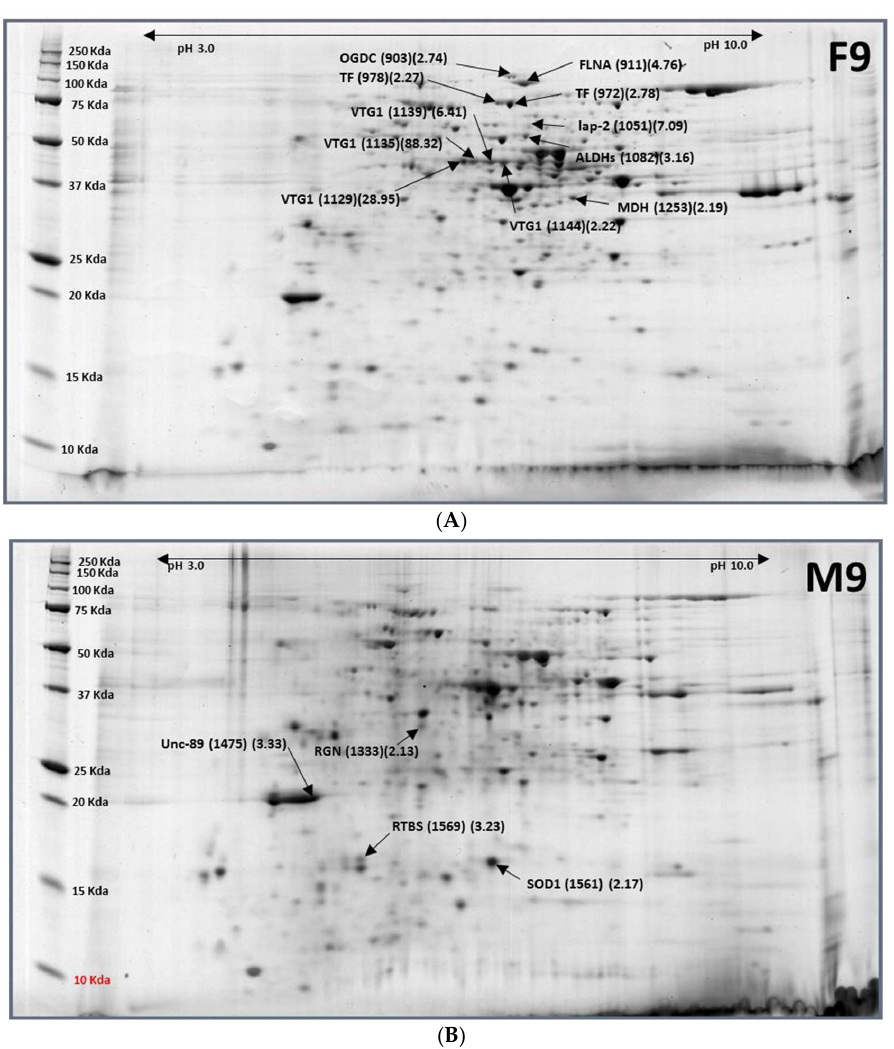
Figure 6. Representative images of 9-day-old females ( A ) and 9-day-old males ( B ) of Bactrocera latifrons . Images were labelled with protein names (spot ID#) (F9/M9 ratios). Table 5. Differentially expressed proteins between 9-day-old females and males of B. latifrons. Accession